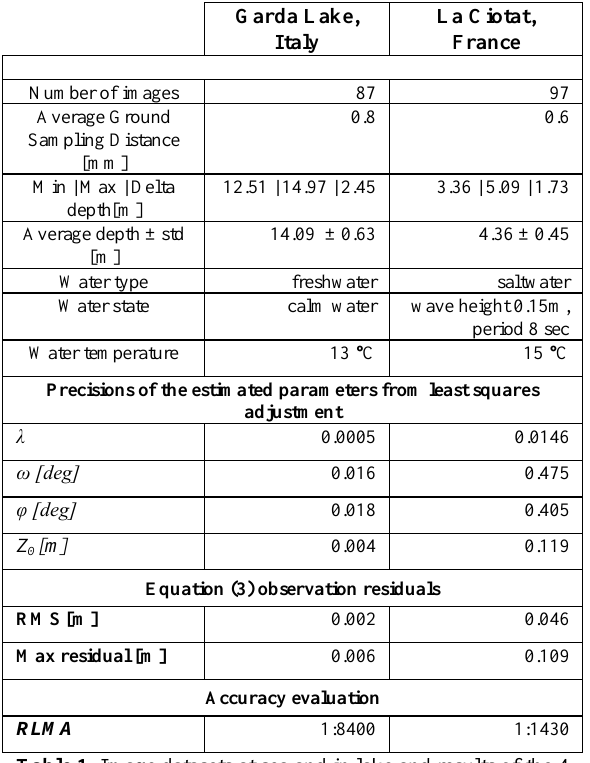
Table 1 . Image datasets at sea and in lake and results of the 4 DOF scaling and levelling